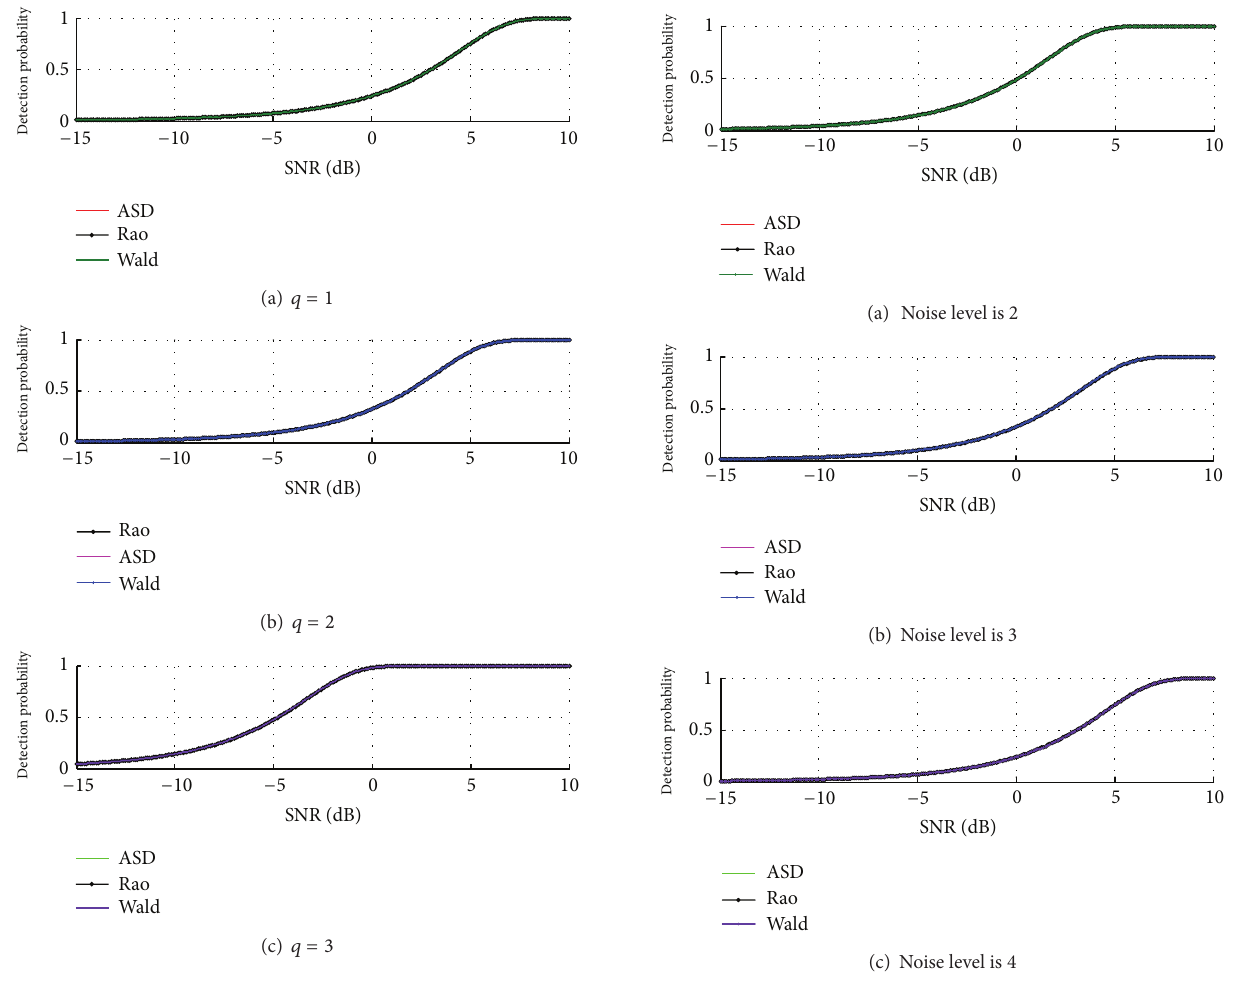
Figure 3: Detection performances of ASD, Rao test and Wald test with 𝑞 = 2 for different noise level 𝜇 = 2, 3,4